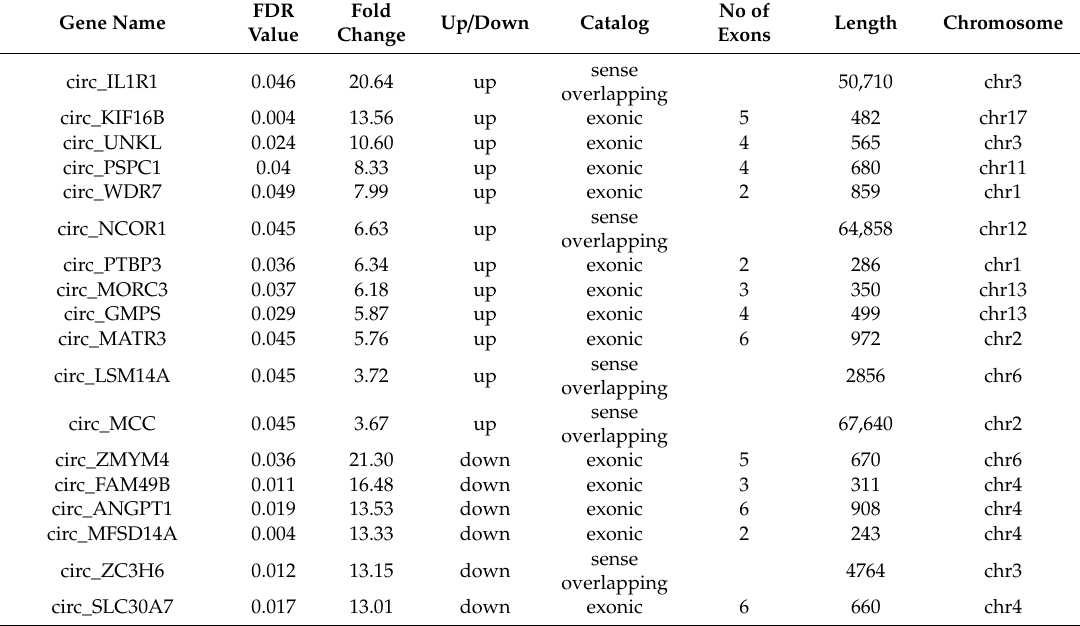
Table 1. Characterization of DE-circRNAs with fold change more than 3 in porcine granulosa cells between healthy and atretic antral